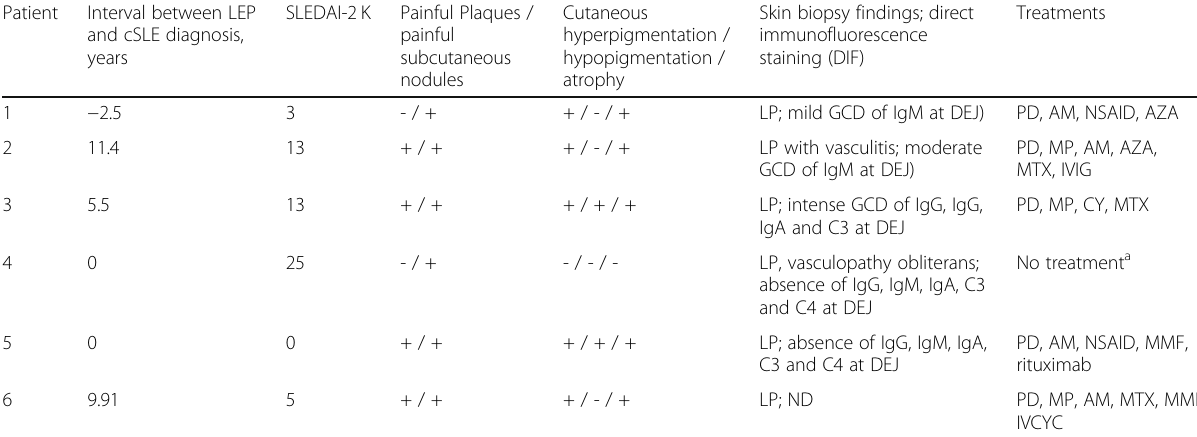
Table 1 Cutaneous manifestations, demographic data, disease activity, outcome, skin biopsy and treatment in six childhood-onset systemic lupus erythematosus (cSLE) patients with lupus erythematosus panniculitis (LEP) Patient Interval between LEP and cSLE diagnosis,